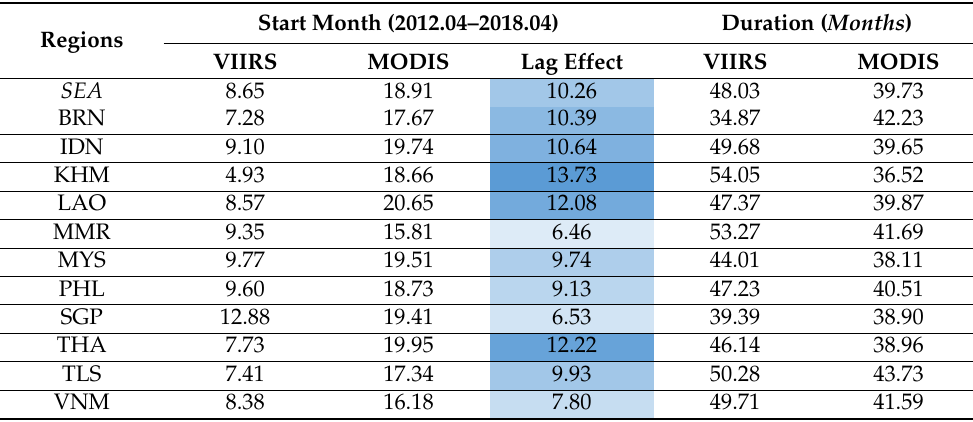
Table 4. The start month and duration between core change period of VIIRS/DNB and MODIS/NDVI time series. The colored cells show the time lag effect of human impacts on vegetation cover change.